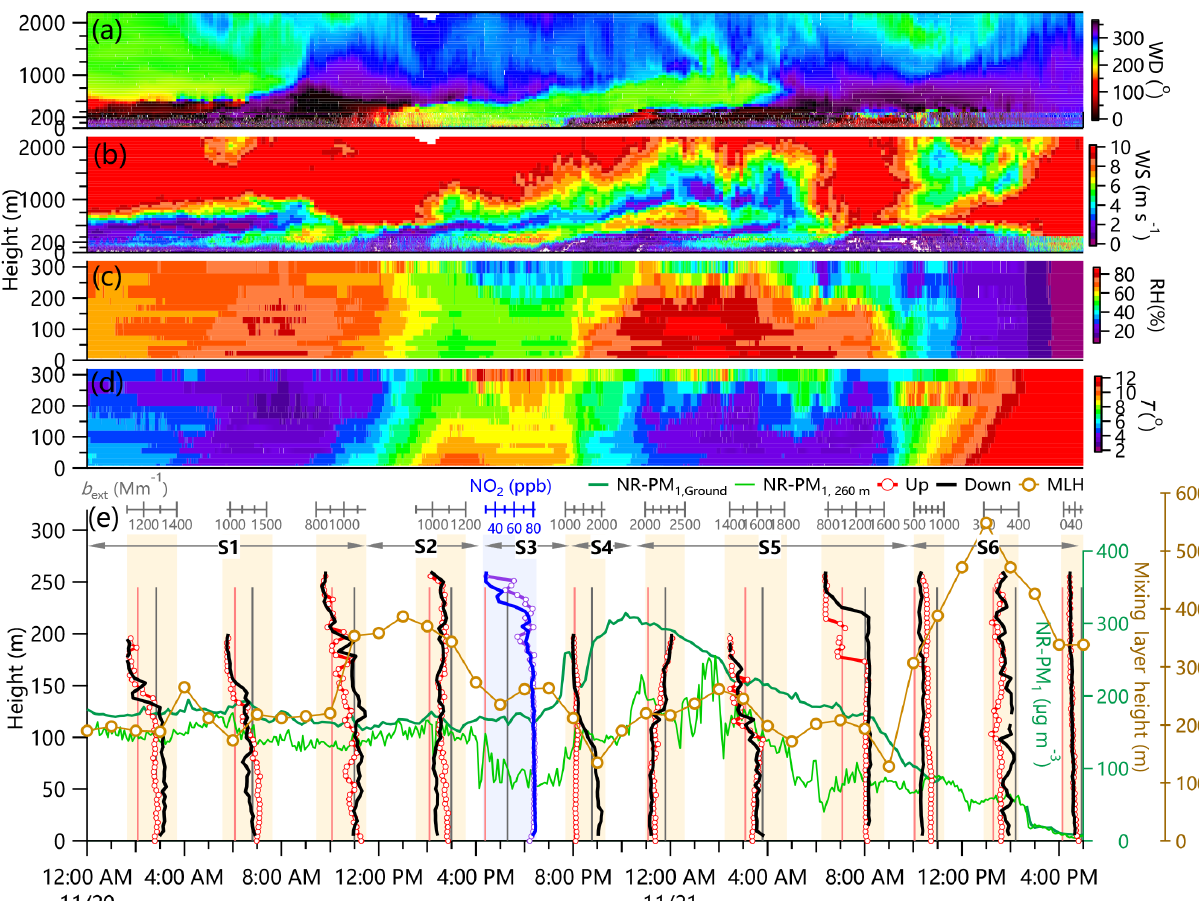
Figure 7. Evolution of vertical profiles of b ext and meteorological parameters from 00:00 on 20 November to 17:00 on 21 November. Also shown are time series of NR-PM 1 mass concentrations at ground level and 260m as well as MLH (right axis). Note that the vertical profiles of b ext between 16:00 and 17:30 were not available due to a malfunction of the CAPS PM ext , therefore, the two vertical profiles of NO 2 were used as surrogates. The shaded areas in panel (e) indicate the time periods for the vertical measurements.